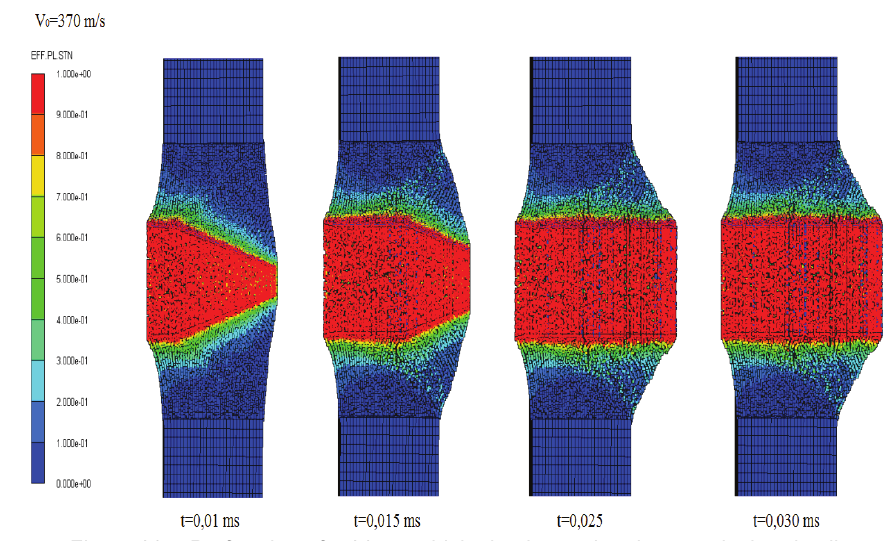
Figure 29 – Perforation of a 20 mm thick aluminum plate by a conical projectile (SFM method)